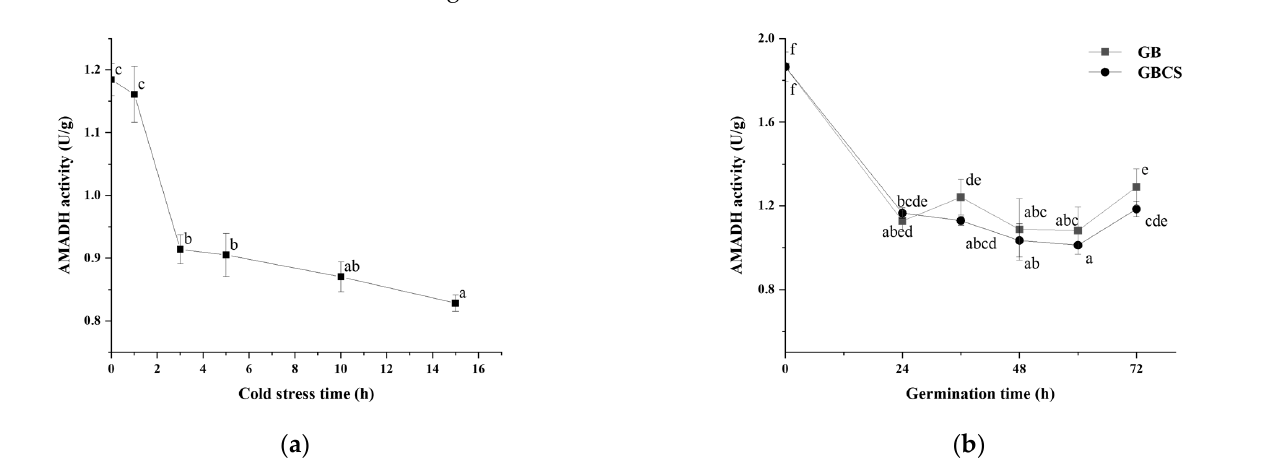
Figure 10. Change in AMADH activity in fl uenced by cold stress and germination. GB, germinated black rice grain without cold stress; GBCS, germinated black rice grain under cold stress at 0 °C for 1 h; ( a ) represents the change in AMADH activity in fl uenced by cold stress time; ( b ) represents the change in AMADH activity in fl uenced by germination time with or without cold stress. Means with di ff erent small le tt er superscripts are signi fi cantly di ff erent at p < 0.05.